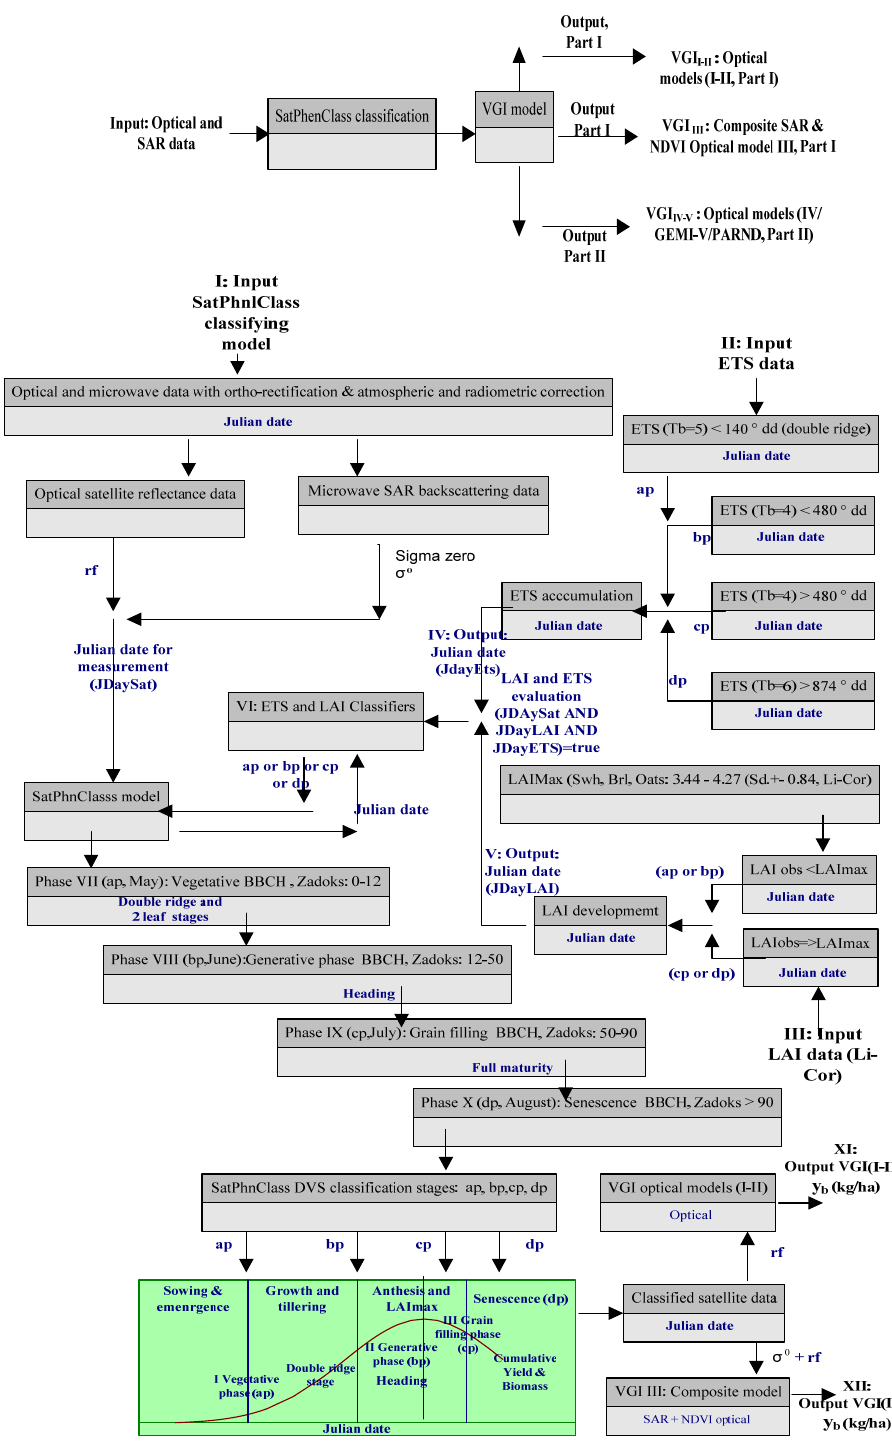
Figure 3. (a) Simplified Black Box diagram for SatPhenClass satellite data classification and VGI models. (b) Satellite data classification diagram for spring cereals, ETS with modifications after Kontturi and Mukula & Rantanen